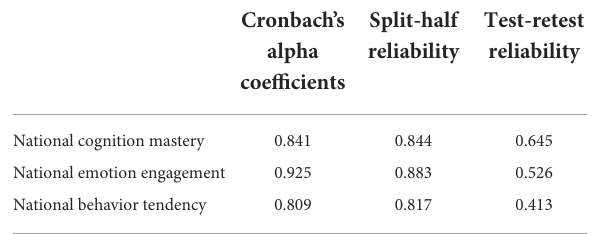
TABLE 4 Results of reliability